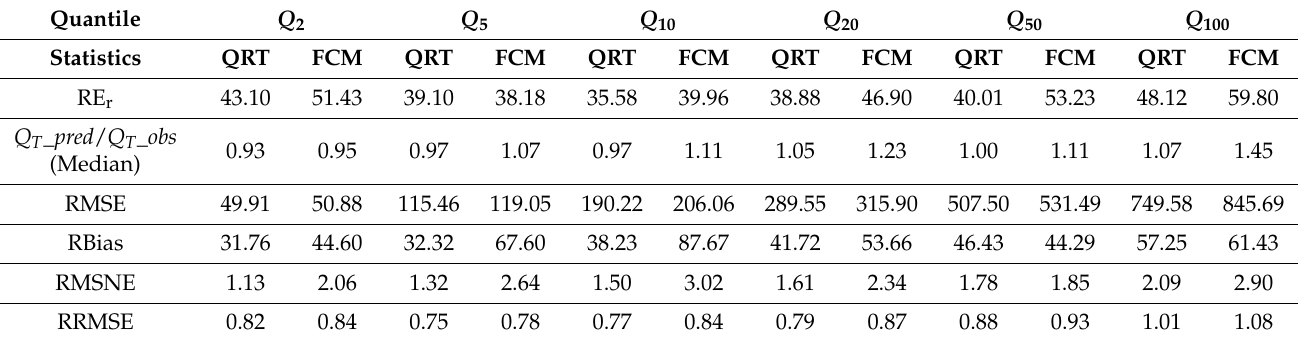
Table 4. Comparison of important statistics between QRT and FCM as the best ANFIS